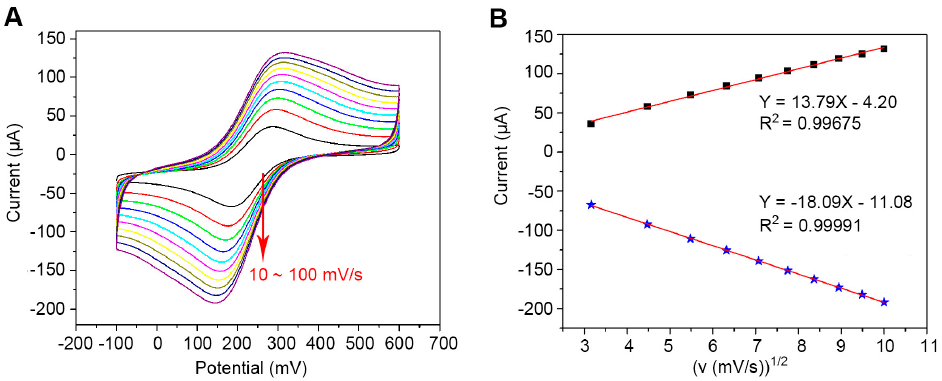
Figure 3. Kinetic analysis of rGO-Au-Pd/GCE indicates that the reaction of the modified electrode is a diffusion-controlled surface reaction. ( A ) Cyclic voltammograms of the sensor in 10 mM K 3 [Fe(CN) 6 ] at scan rates ranging from 10 to 100 mV/s. ( B ) Linear fits of the oxidized peak current (Ipa) and reduced peak current (Ipc) versus the square root of the scan rate (v 1/2 ).